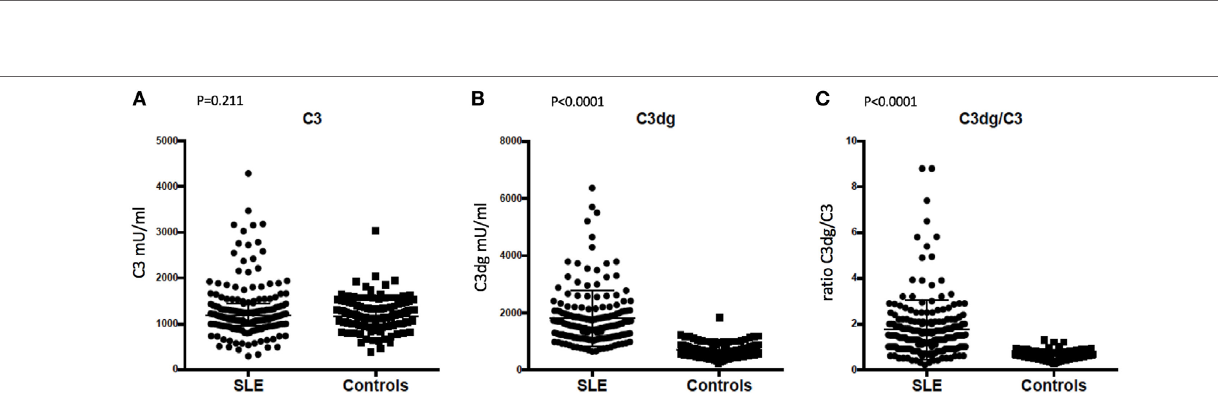
FigUre 3 | Time-resolved immuno fluorometric assay (TRIFMA) and enzyme-linked immune sorbent assay (ELISA) C3dg assays compared. (a) shows the standard curve of the assay carried out using europium-label (TRIFMA) and (B) as ELISA. (c) Correlation (Spearman) between measurements of C3dg on EDTA plasma samples using our assay as TRIFMA and as ELISA.